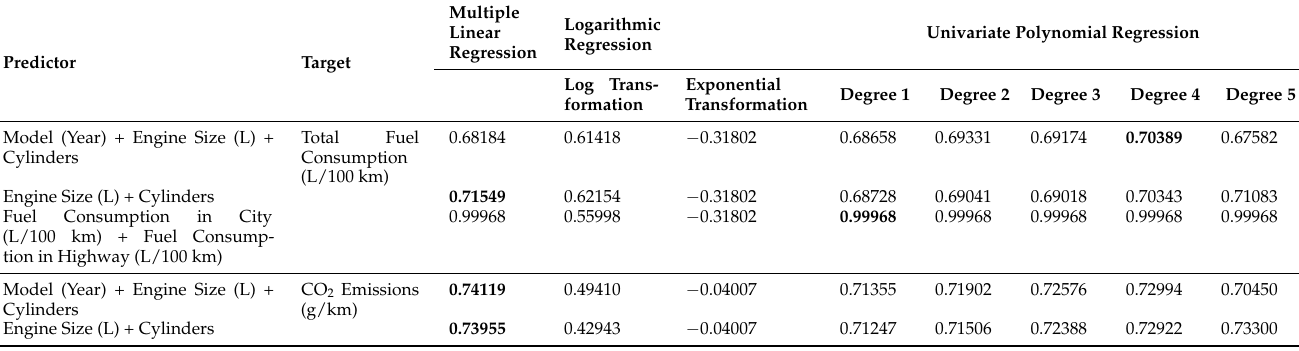
Table 13. Coefficient of determination (R squared) values of Multiple Linear Regression, Loga- rithmic Regression, Multivariate Polynomial Regression, Transformation of data, and Exponential Regression models.